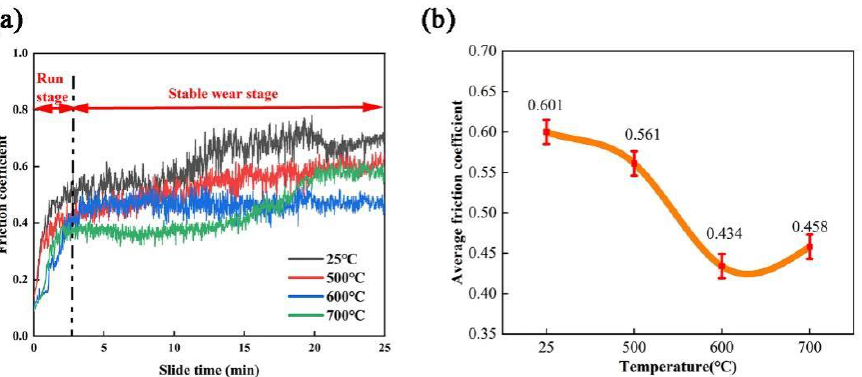
Figure 9. ( a ) Friction coefficient of the composite coatings with different heat-treatment temperatures; ( b ) average friction coefficient of the composite coatings with different heat-treatment temperatures .